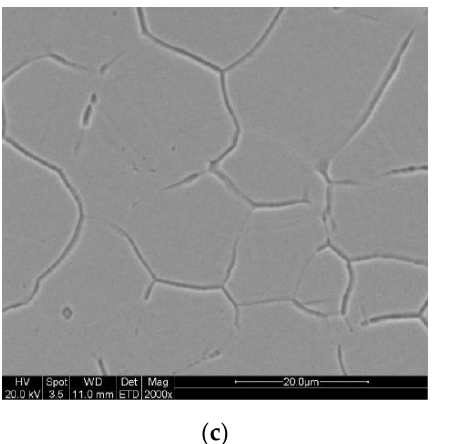
Table 4. Element composition (wt %) measured on colored specimens’ surfaces.